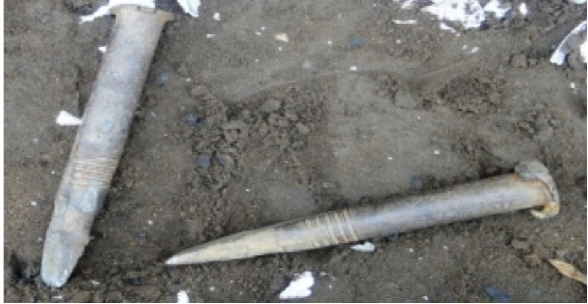
Figure 6 | Variants of pritchels (for creating holes). Photograph by Kingsley O. Emeriewen, 2012.